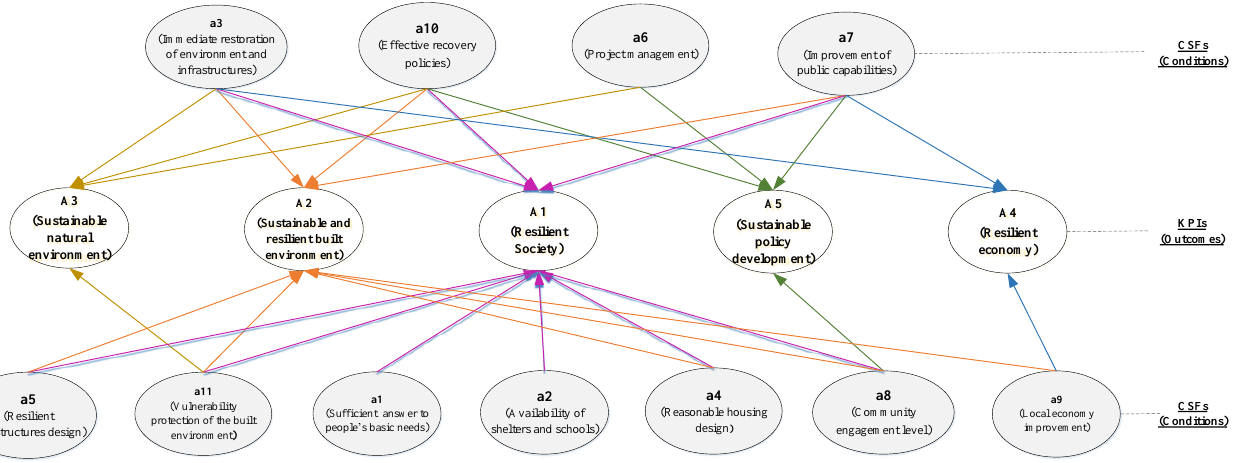
Figure 3. Success evaluation framework.